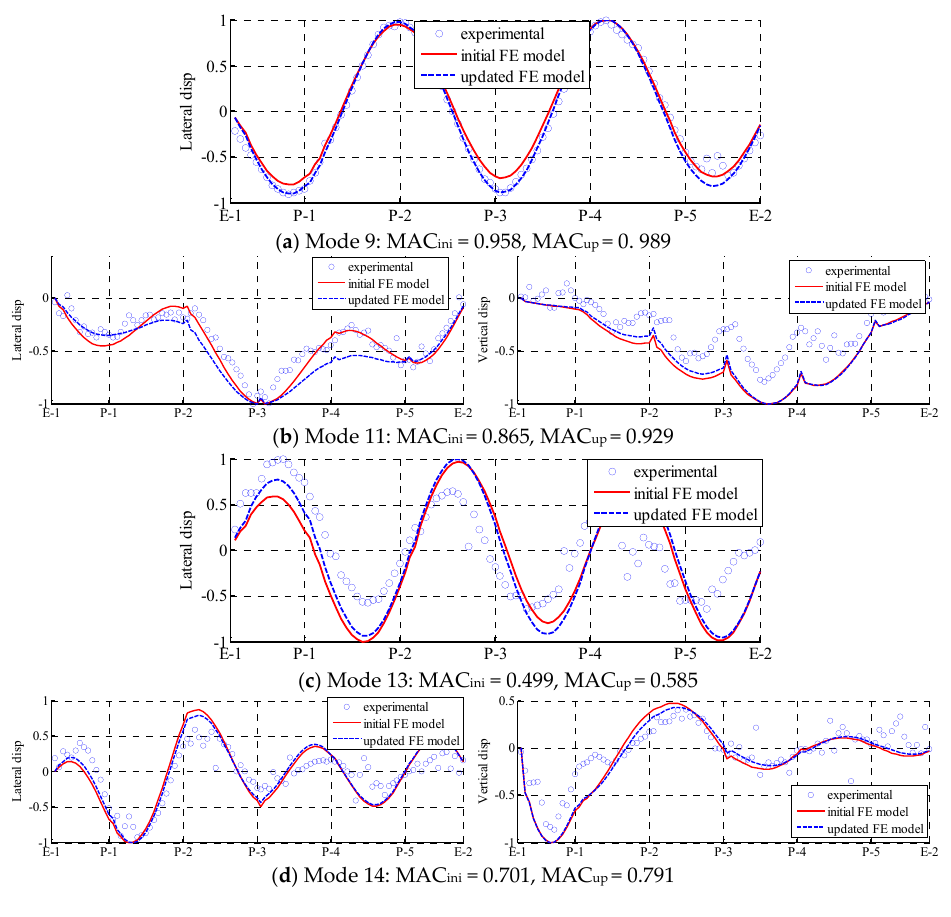
Figure 7. Lower modes that can be identified from pure ambient and combined free–ambient vibration: comparison of mode shapes among experimental values (dot), initial FE model (solid line), and updated FE model (dash line).